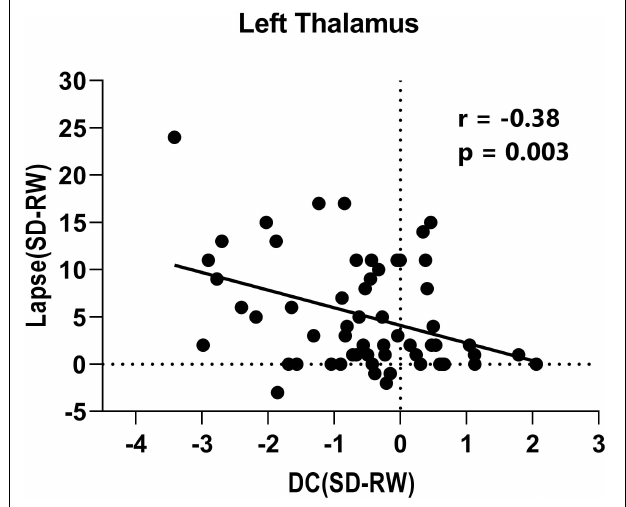
FIGURE 4 | Correlation between change of lapse of psychomotor vigilance task and change of degree centrality within left thalamus.